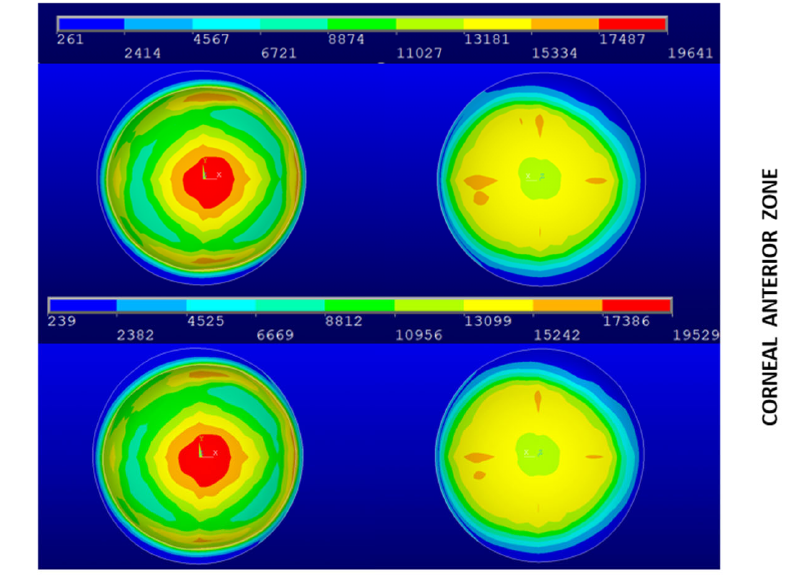
Figure 6. Stress distribution in measurement phase for cornea G1. Displacement method ( Upper ), Prestress method ( Lower ).